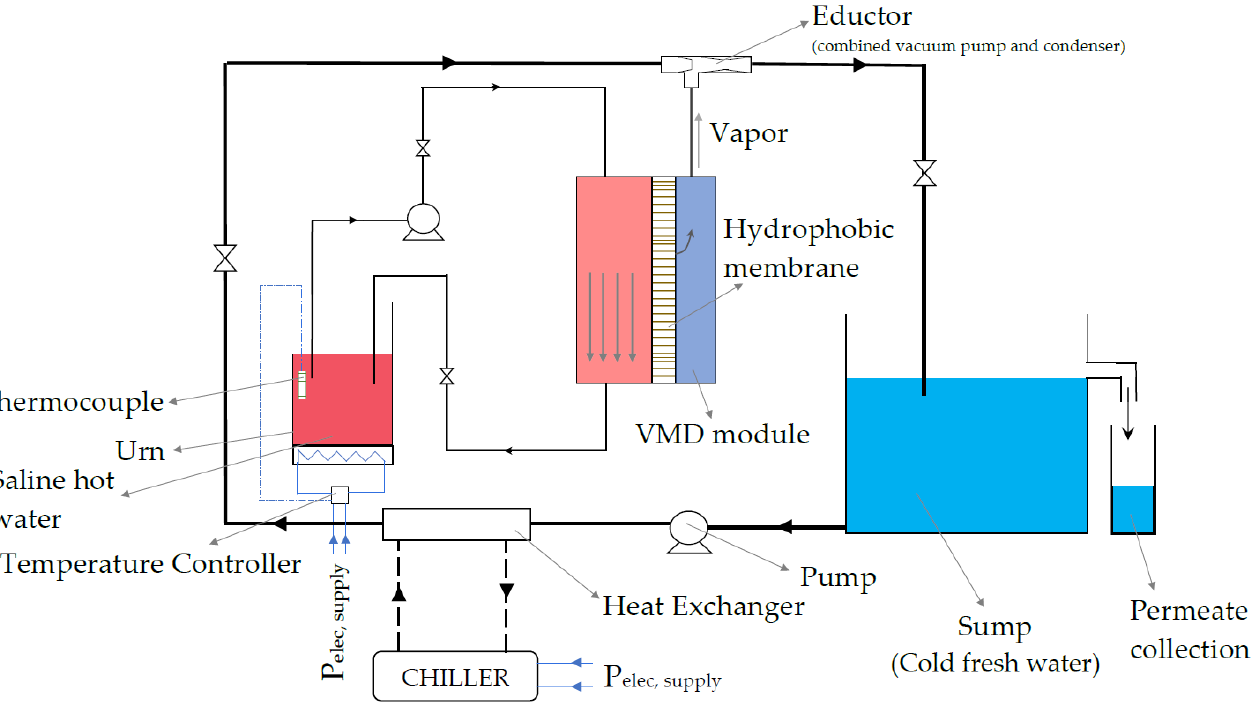
Figure 4. Eductor-based membrane distillation unit.